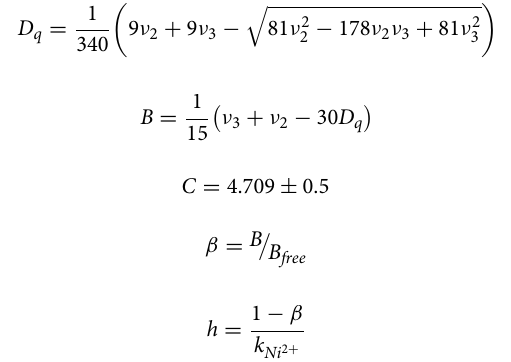
Ni 3+ (3d 7 ) ion, 4 A 2g ( 4 F) → 4 T 1g ( 4 P) transition in the tetrahedral Ni 3+ (3d 7 ) ion, and the allowed 3 A 2g ( 3 F) → 3 T 1g ( 3 P) transition in octahedral the Ni 2+ (3d 8 ) ion 24–26 . The band at 707 nm harmonious to the forbidden transition 3 A 2 ( 3 F) → 3 E 1g ( 1 D) in Ni 2+ octa- hedral , while that is at 779 nm due to the allowed transition 3 A 2g ( 3 F) → 3 T 1g ( 3 F) in Ni 2+ tetrahedral 24–26 . The observed band at 863 nm assigned to 3 A 2g ( 3 F) → 3 T 1g ( 3 F) allowed electronic transition in octahedral Ni 2+ ions. The band at 1286 nm is due to 3 A 2g ( 3 F) → 3 T 2g ( 3 F) allowed electronic transition in octahedral Ni 2+ ions 27,28 . The → 4 T 4 F) in Ni 3+ tetrahedral 25,27,28 . The appearance of three distinct bands for N 3+ , especially 2g (F) 2g (